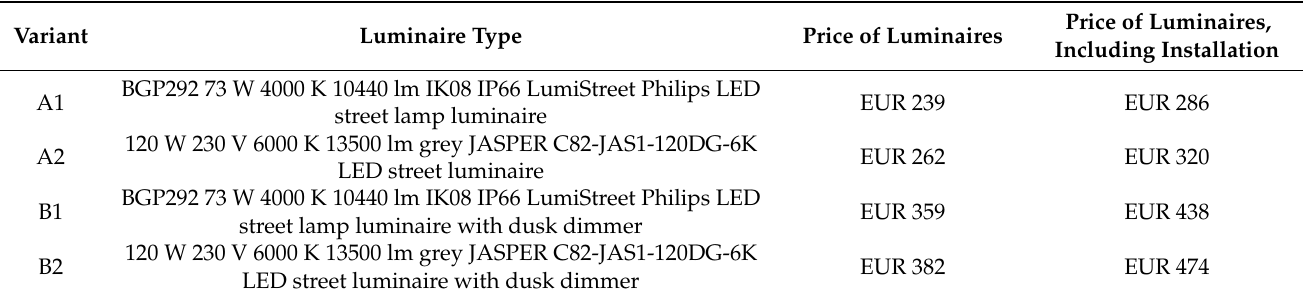
Table 5. Summary of luminaires with installation